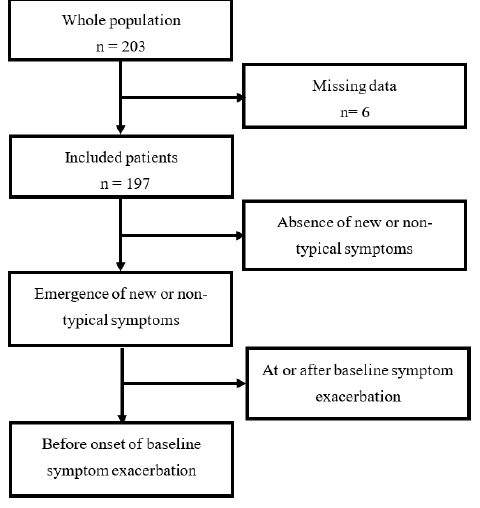
Figure 1. Flow chart.